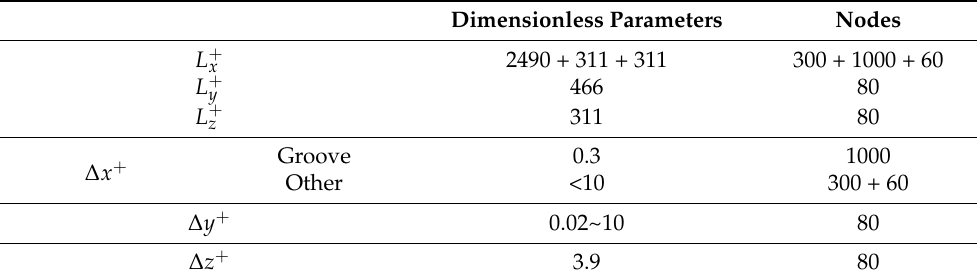
Table 1. Size of the computational domain and the corresponding number of grid nodes.